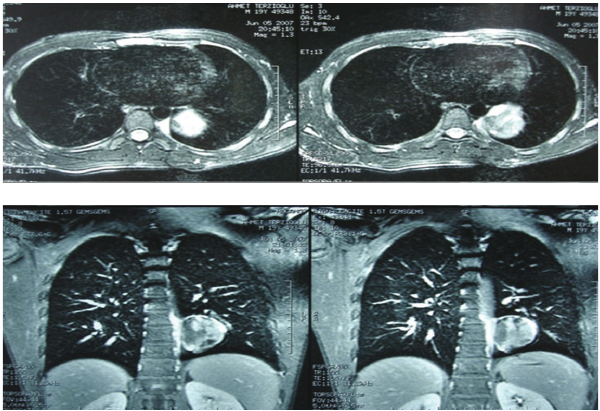
Figure 2: On the thorax MR angiography a 6 × 6.5 cm, oval-shaped, pleural based mass in the left lower lobe was seen.